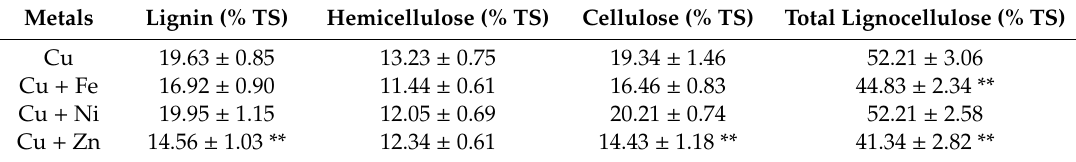
Table 3. The average contents of cellulose, hemicellulose, lignin and total lignocellulose during the